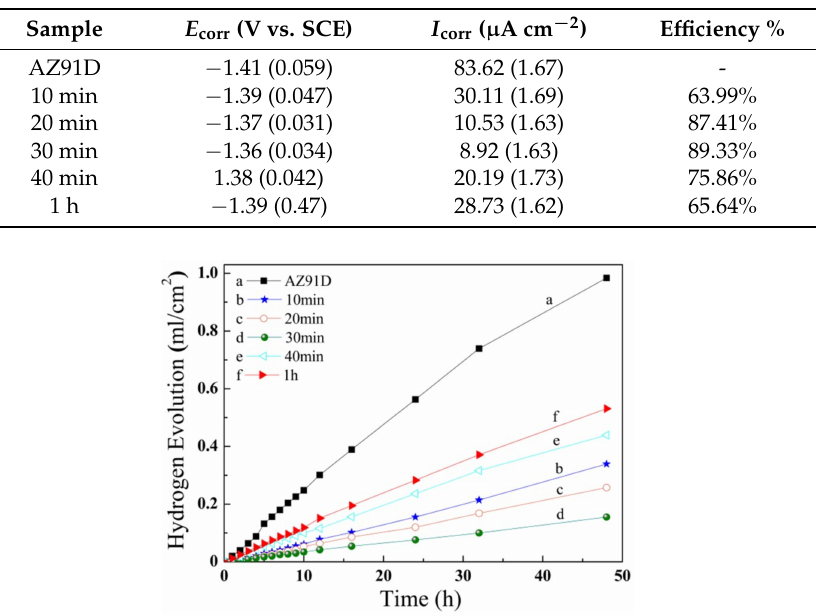
Figure 10. Hydrogen evolution curves of the LDHs coatings at different formation times in 3.5% NaCl solution.